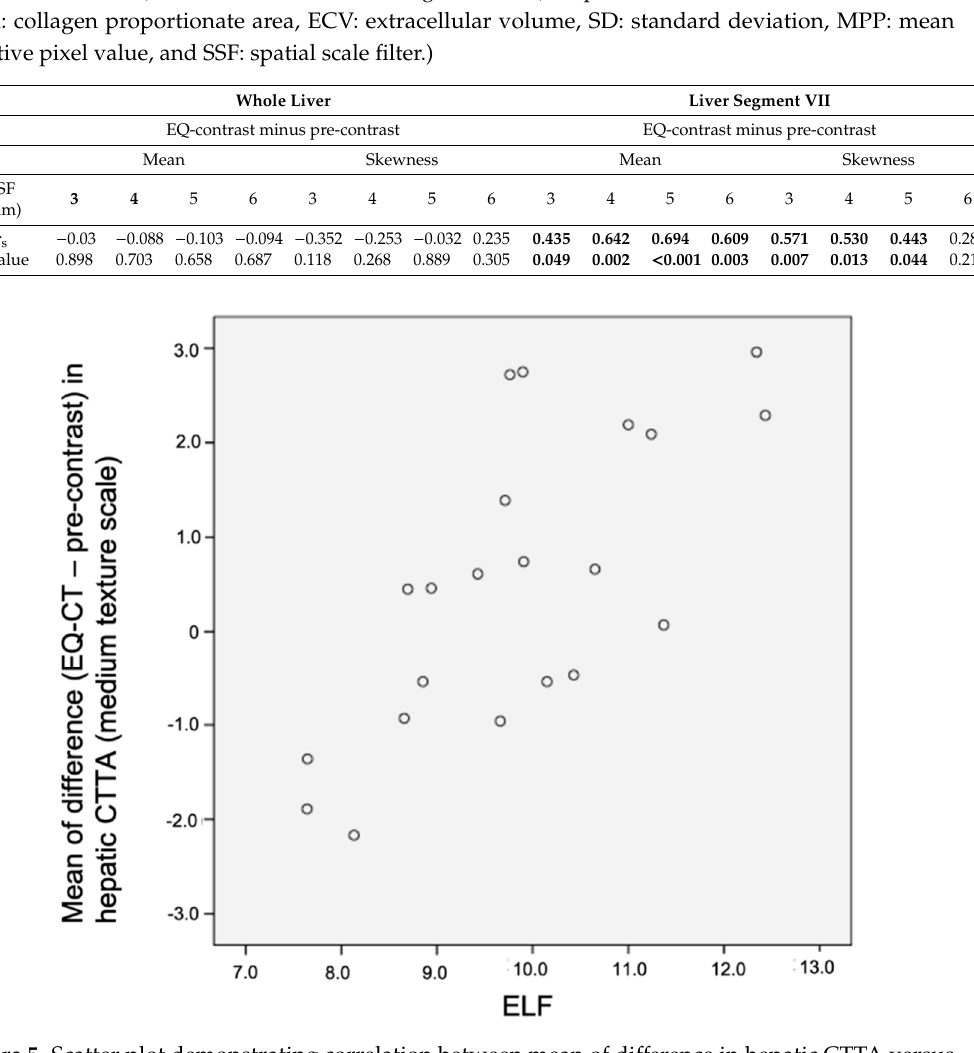
Table 1. Summary of texture liver analysis results for coarse (SSF: 6 mm) and medium texture scales (SSF: 5, 4 and 3 mm). Bold indicates statistical significance. (r s : Spearman’s rank correlation coefficient, CPA: collagen proportionate area, ECV: extracellular volume, SD: standard deviation, MPP: mean positive pixel value, and SSF: spatial scale filter.)